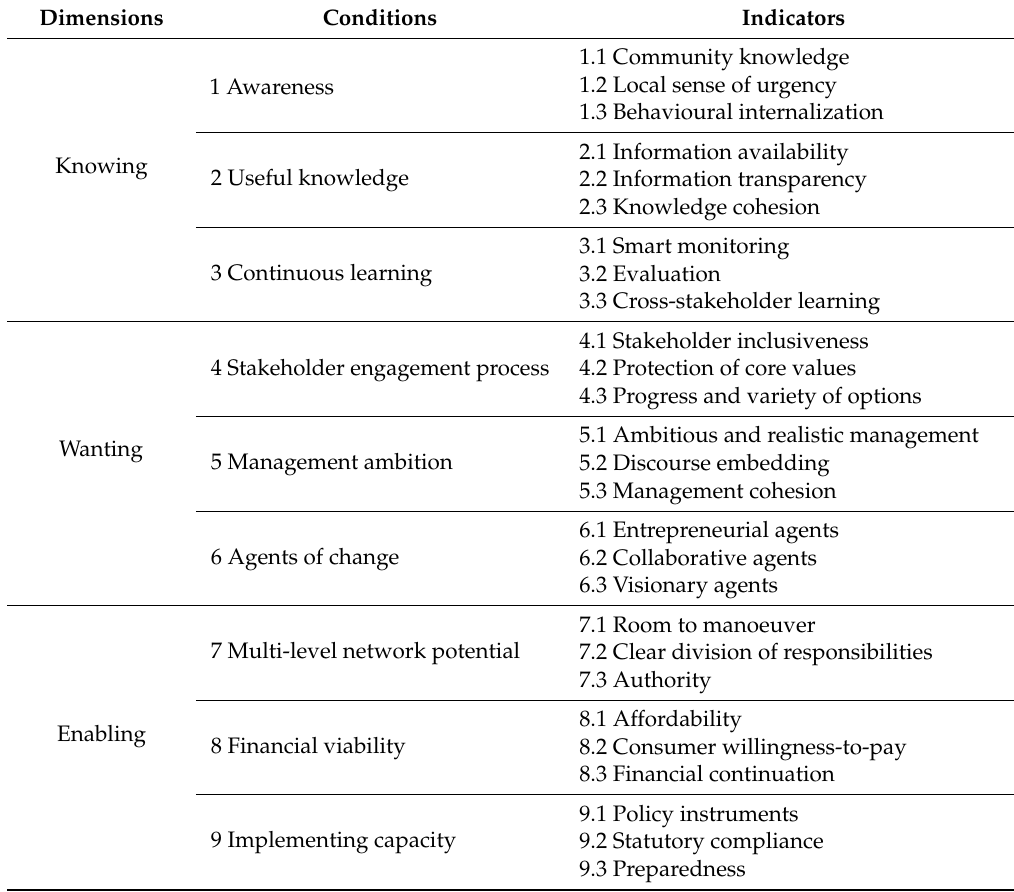
Table 1. Water Governance Capacity Framework (GCF)